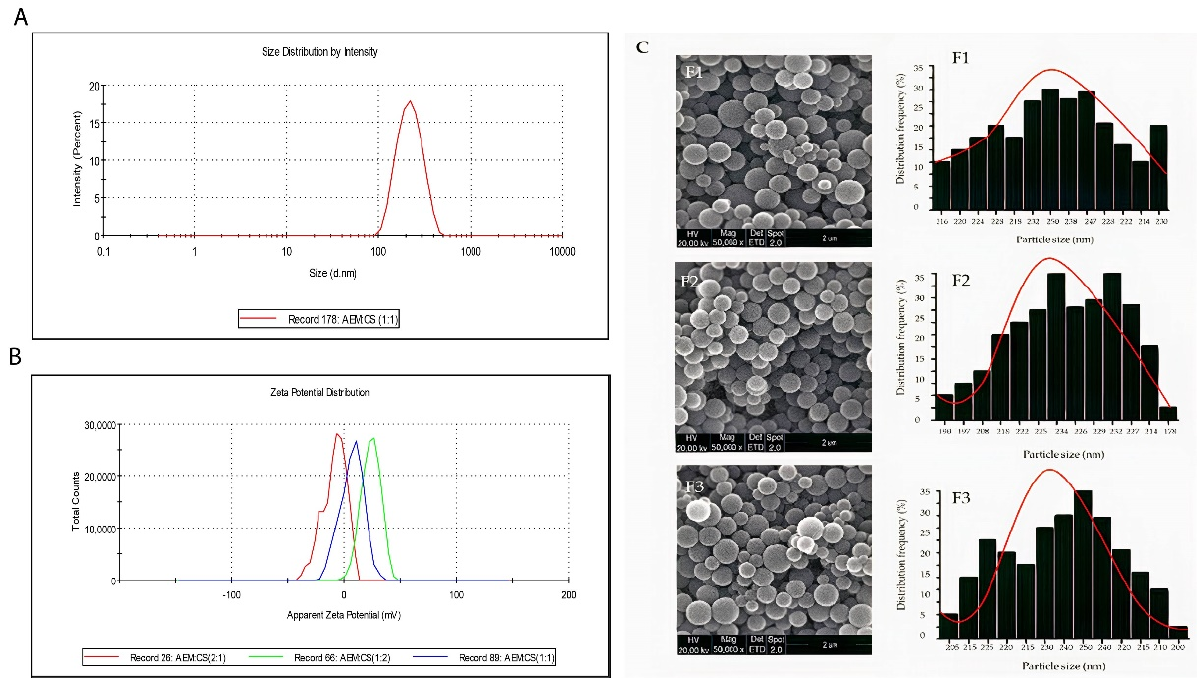
Figure 3. ( A ) Z-average d. nm AEM:CS at 1:1 ratio. ( B ) Zeta-potential (mV) of AEM:CS at the ratios